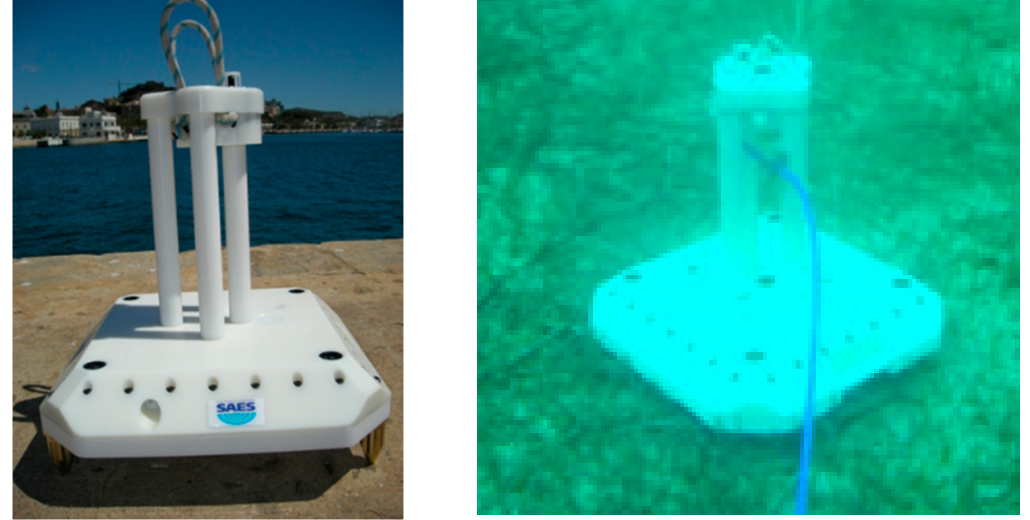
Figure 2. Bottom-mounted underwater multi-Influence sensor before being deployed ( left ), and deployed at sea ( right ). The sensor unit integrates magnetic, electric, seismic, pressure and acoustic sensors. The hydrophone is mounted on the top of the unit, being at a distance from the sea bottom less than 1 m, in accordance with the standard STANAG 1136 [62].